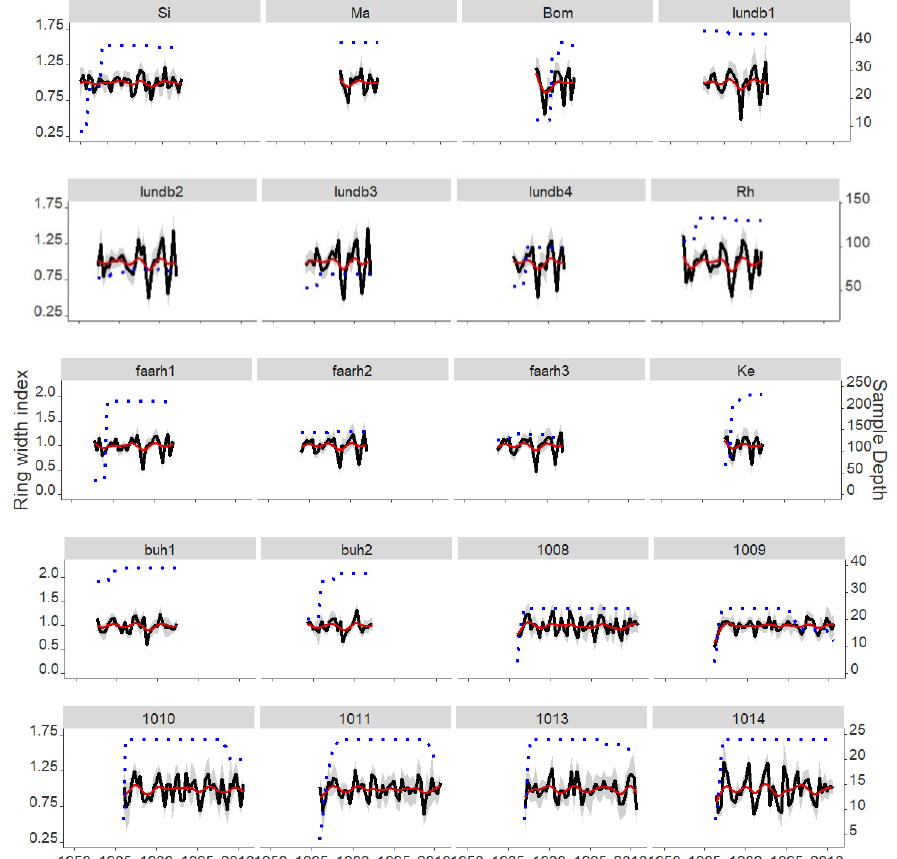
Figure 2. Standardized tree-ring width indices for each studied plantation stand and common garden trial. The black line refers to the average chronologies; the grey-shaded area indicates the standard deviation of single time-series; and the red line shows the 10-year cubic spline function used for standardization. Sample depth is indicated by the blue dotted line related to the second y-axis.